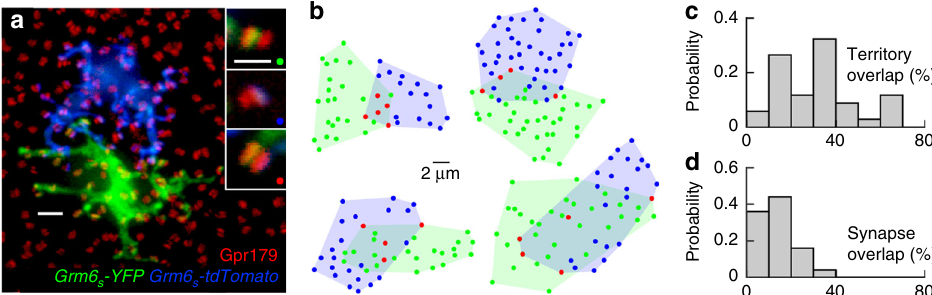
Fig. 2 RBC dendrites overlap and share rod input. a Maximum intensity projection of a confocal image stack of two adjacent RBCs labeled with spectrally separable fl uorophores via AAVs ( Grm6 S -tdTomato in blue and Grm6 S -YFP in green). RBC postsynaptic sites are stained for Gpr179 (red). For visual clarity, the two RBCs were digitally isolated in Amira. Scale bar represents 2 μ m. Insets on the right show higher magni fi cation views of Gpr179 clusters contacted by either (top two panels) or both (bottom panel) RBCs. Scale bar represents 1 μ m. b Representative examples of dendritic and synaptic overlap of four pairs of RBCs. Shaded areas represent dendritic territories. Rods targeted by dendrites of either RBC are marked by green and blue circles; rods targeted by dendrites of both RBCs are indicated by red circles. c , d Distributions of dendritic territory overlap ( c , n = 37 pairs, n = 10 mice) and synaptic overlap ( d , n = 28 pairs, n = 8 mice) between neighboring RBCs